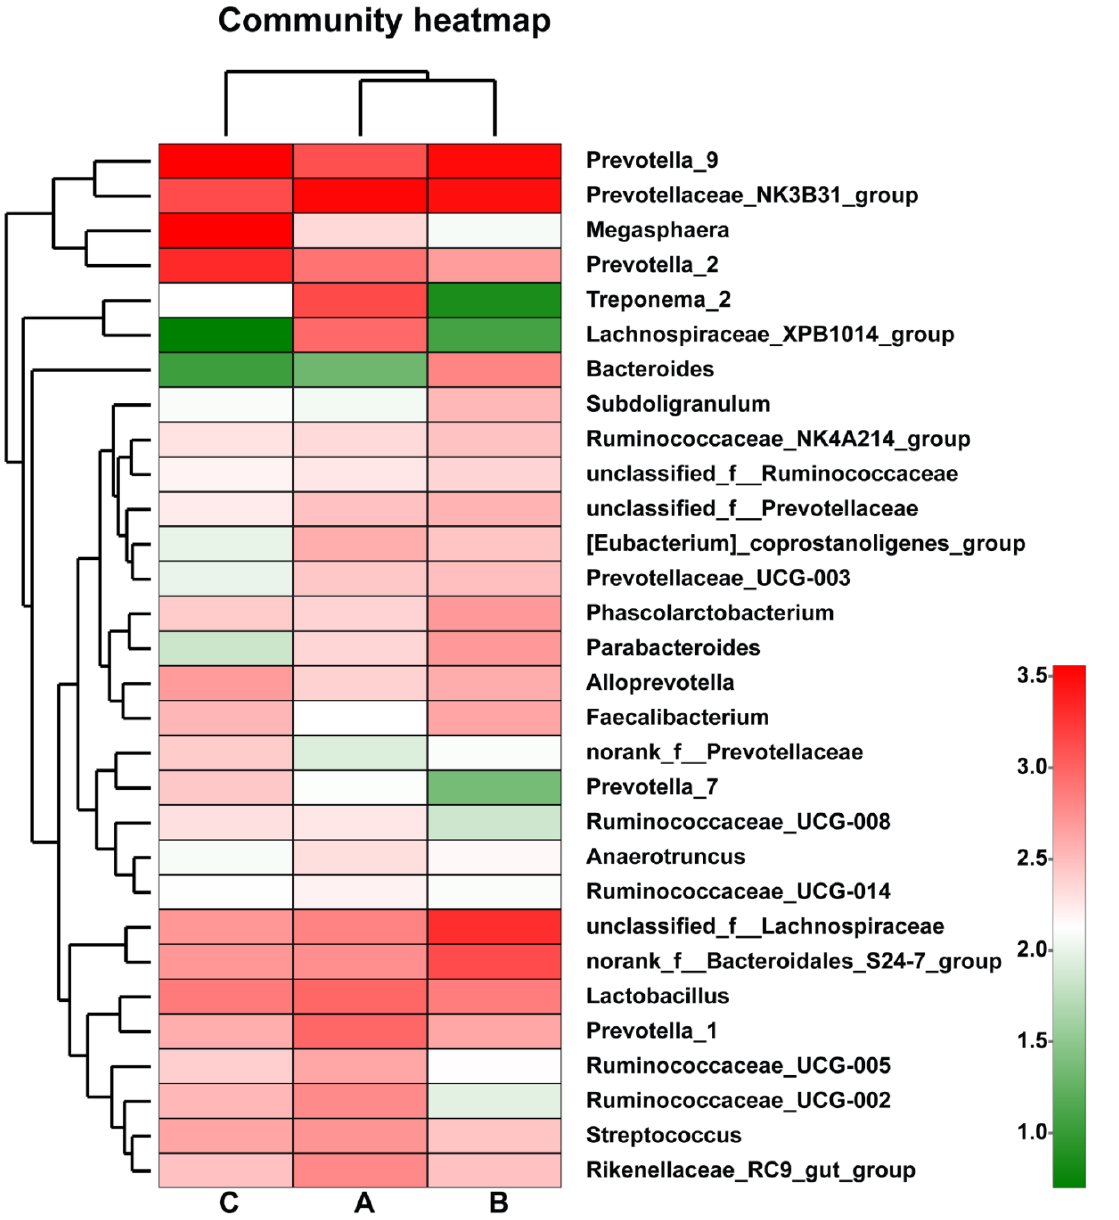
Figure 4. Microbial community heatmap of top 30 bacteria on the genera level. The different colors represent the relative abundance of bacteria in groups A, B and C. The red color means higher relative abundance, whereas the green color means lower relative abundance. Group A: basal diet; group B: basal diet supplemented with antibiotics and zinc oxide; group C: basal diet supplemented with 0.06% CPB.